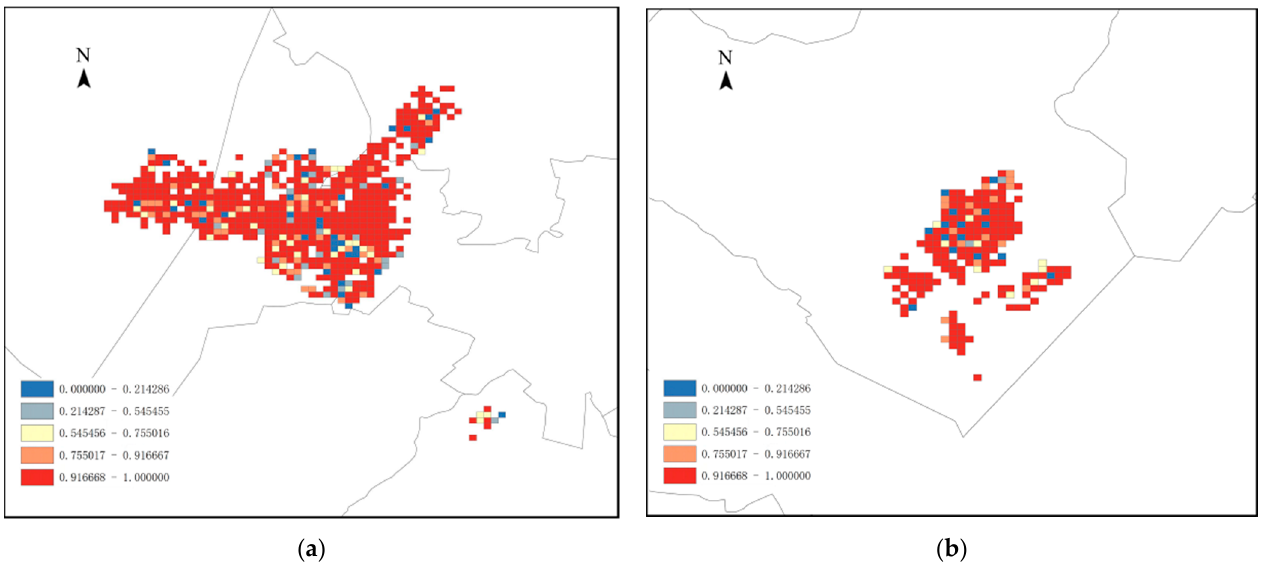
Figure 12. ( a ) Spatial distribution of prediction accuracy in the central urban area of Yinchuan; ( b ) Spatial distribution of prediction accuracy in the central urban area of Shizuishan.